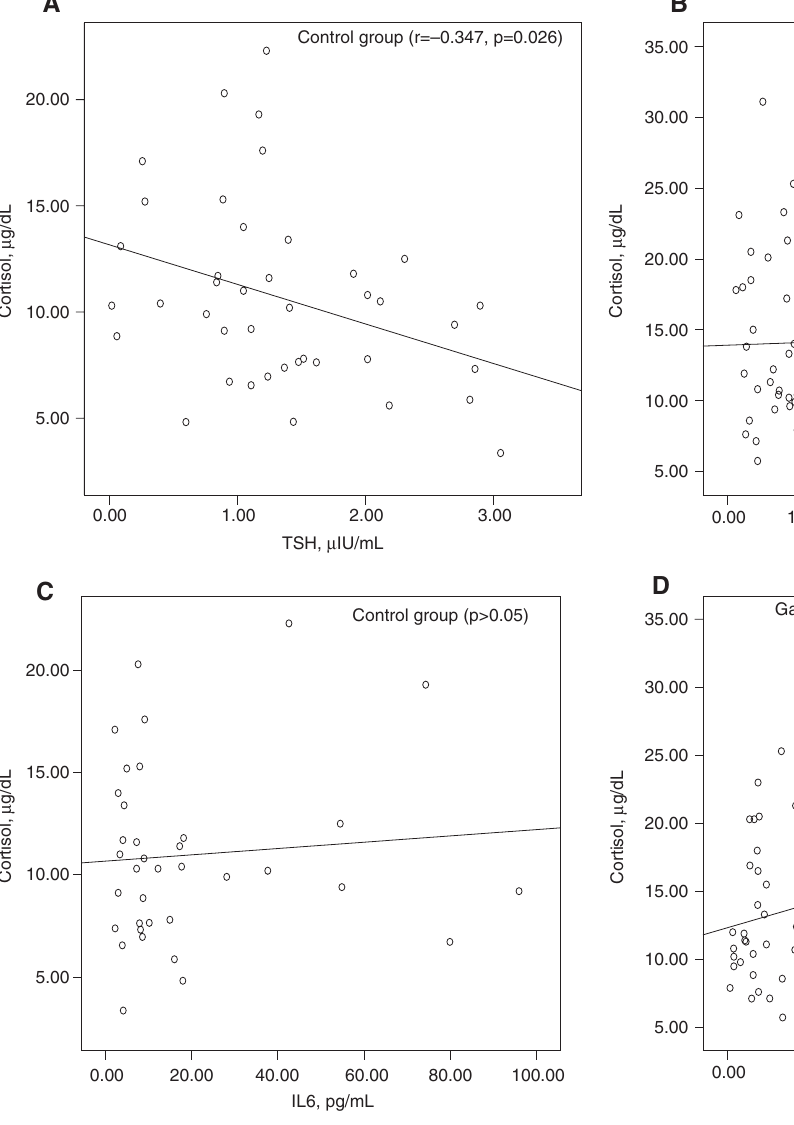
Figure 2: Results of the linear regression analysis of overall gastrointestinal cancer cases and control group. p < 0.05 was considered to be statistically significant. A, C, E: the graphics of gastrointestinal cancer cases, B, D, F: the graphics of control